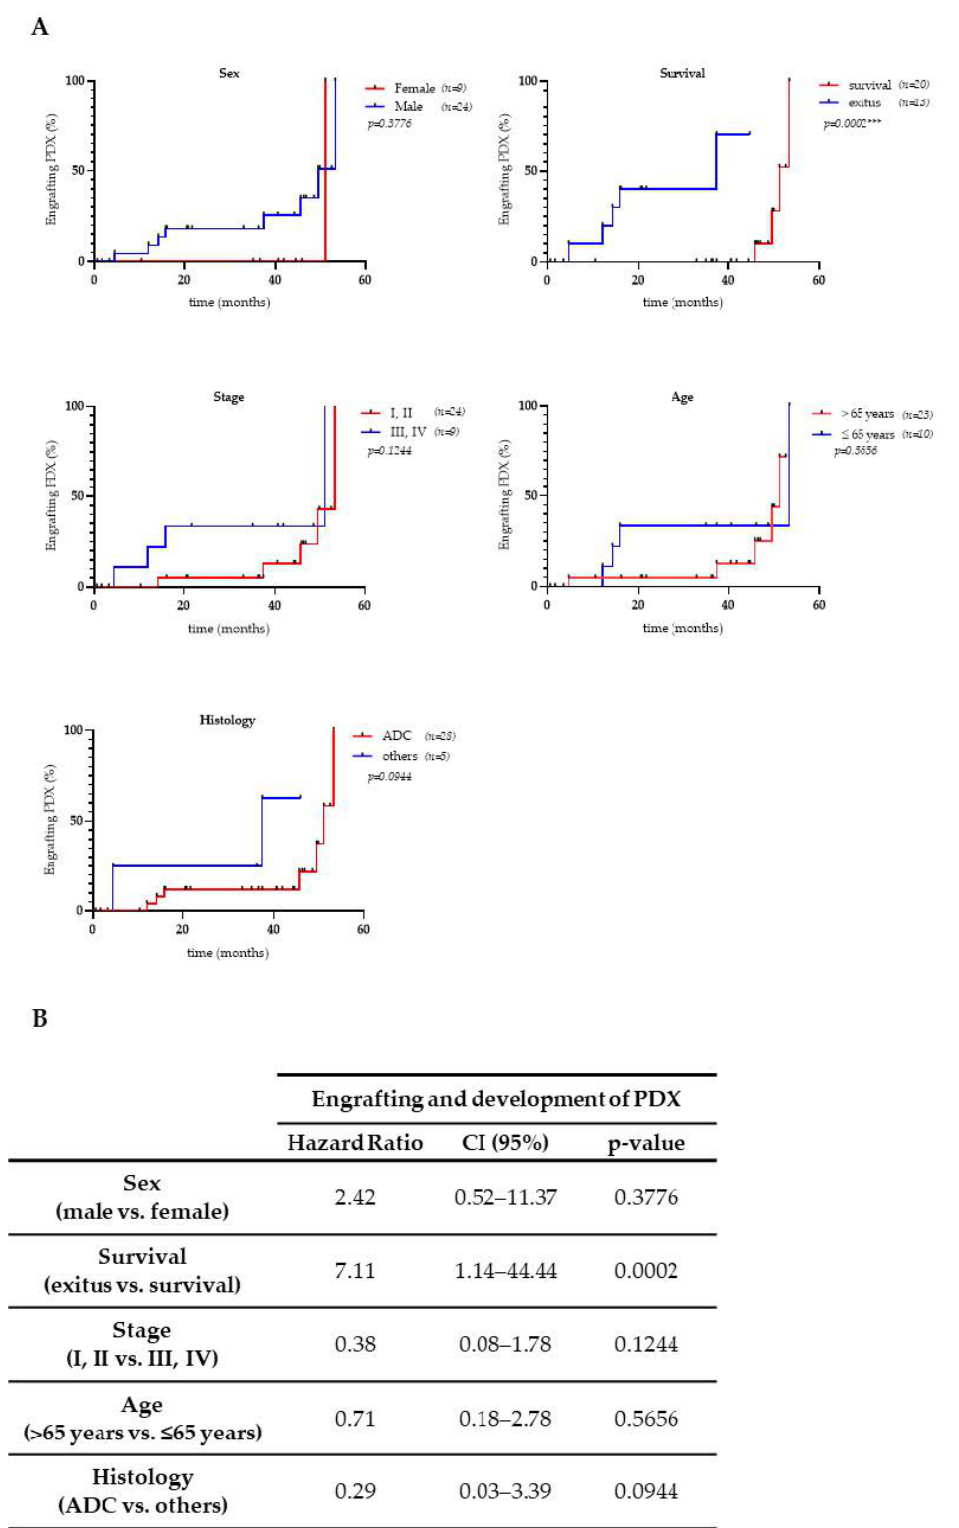
Figure 2. Cumulative incidence of the PDX grafting success according to clinicopathological variables. ( A ) Cumulative incidence curves showing engrafting PDX fractions throughout the follow-up period, related to each patient’s clinicopathological characteristics; ( B ) log-rank test results (Mantel-Cox) correlating PDX implantation success and the different clinicopathological characteristics. Hazard ratios, confidence intervals (95%), and p -values are shown. PDX: patient-derived xenograft; ADC: adenocarcinoma; CI: confidence